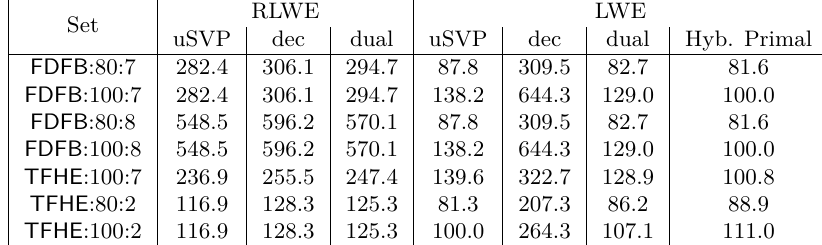
Table 3: Security estimations for the parameter sets. This table contains the the security estimates obtained by running the LWE estimator [APS15] for RLWE and LWE samples. The numbers represent base two logarithms of estimated required ring operations to lunch a sucessfull attack.